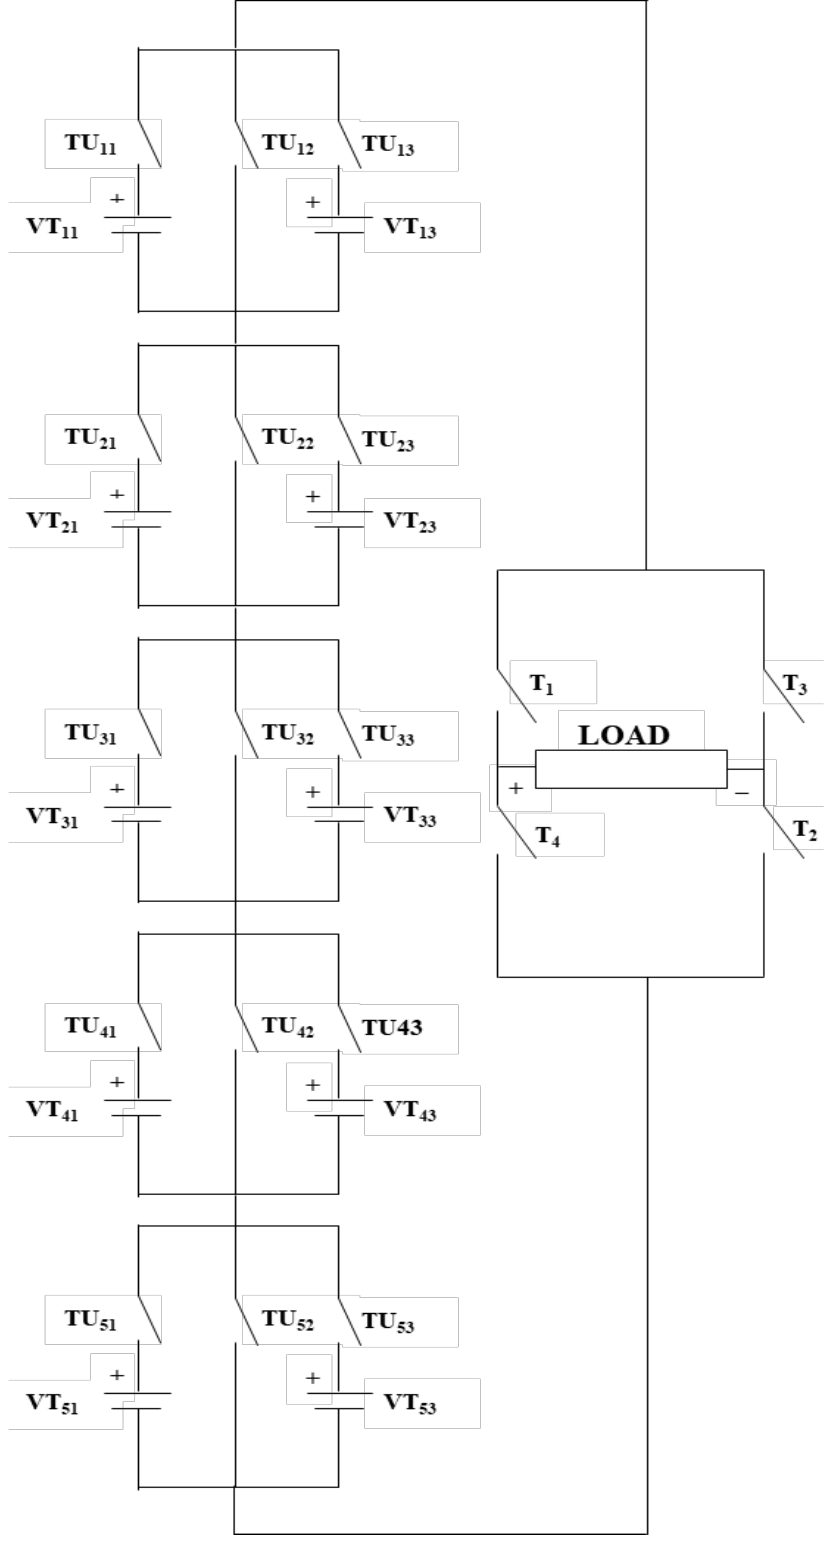
Figure 4. Development of 485 level inverter using Tri-state architecture.